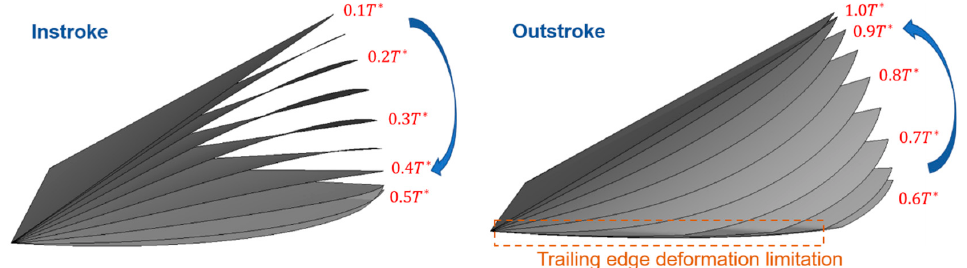
Figure 6. The surface deformation during flapping.